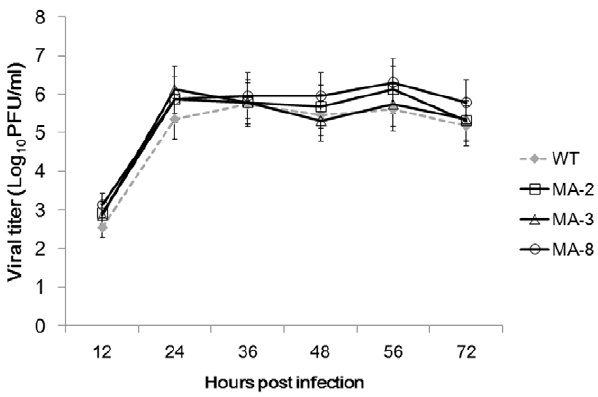
Figure 2. The replication kinetics of wild-type and mouse- adapted seasonal H1N1 A/Brisbane/59/2007 viruses in MDCK cells. MDCK cells were infected in triplicate with 25 PFU of each virus, respectively. The viral yields (log10 PFU/ml) were measured at 12, 24, 36, 48, 56, and 72 h.p.i. Data are expressed as mean 6 SD of viral titers (log10 PFU/mg) of each group of cells from three separate experiments.